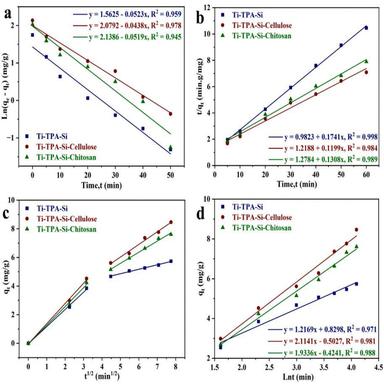
(a) Pseudo-first-order, (b) Pseudo-second-order, (c) Intraparticle diffusion, and (d) Elovich kinetics for the adsorption of TTC onto Ti-TPA-Si, Ti-TPA-Si-C, and Ti-TPA-Si-CS adsorbents at 35 ◦C.